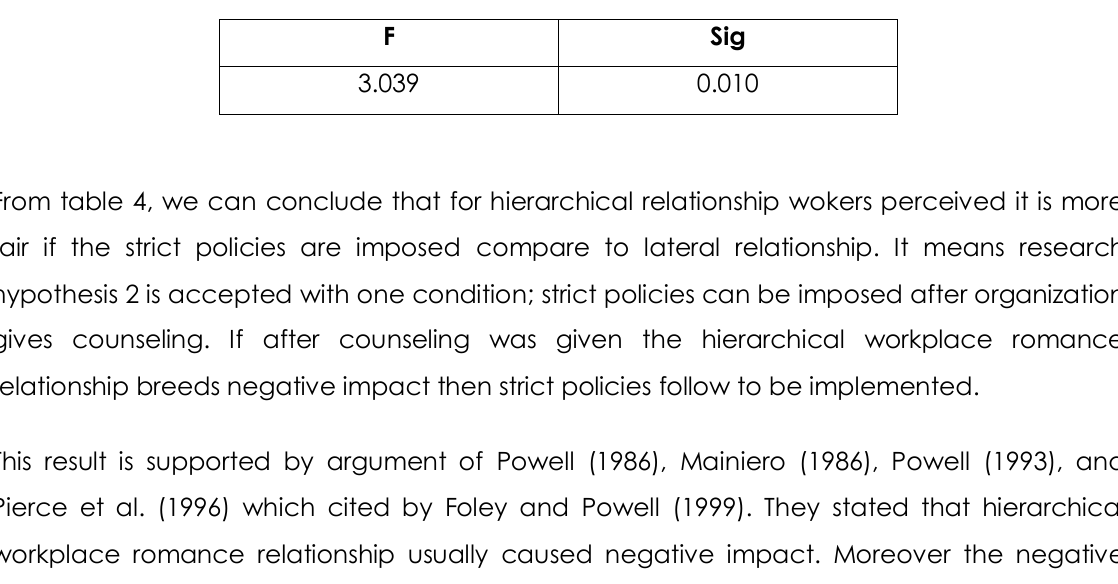
Table 6. ANOVA Table of Hypothesis